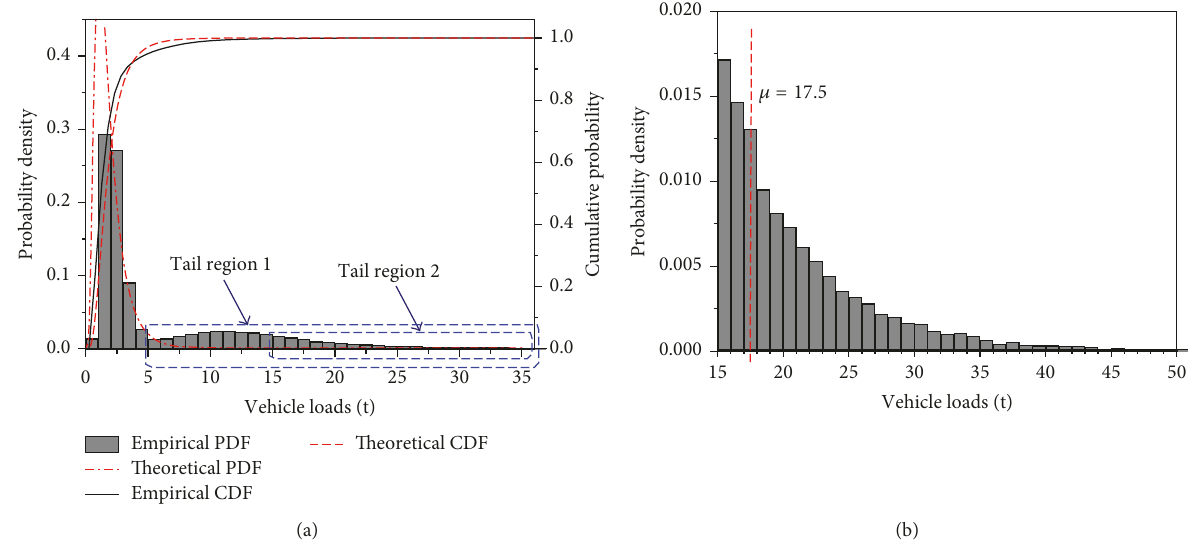
Figure 3: Mixture distribution of the simulated data: (a) entire range and (b) tail region.